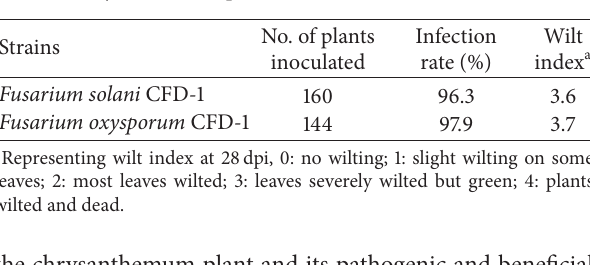
Table 4: The pathogenicity of two Fusarium sp. isolates present in diseased chrysanthemum